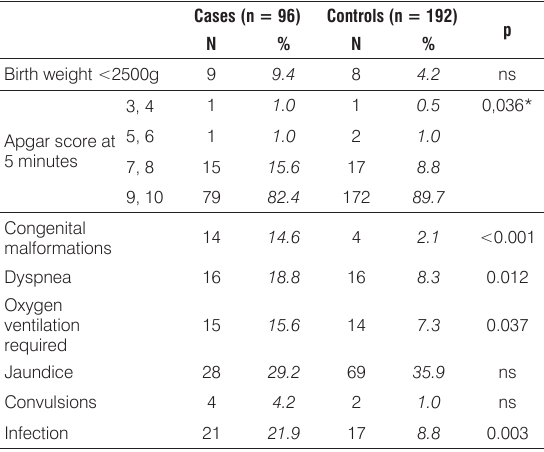
Table 3. Neonatal characteristics of cases and controls.